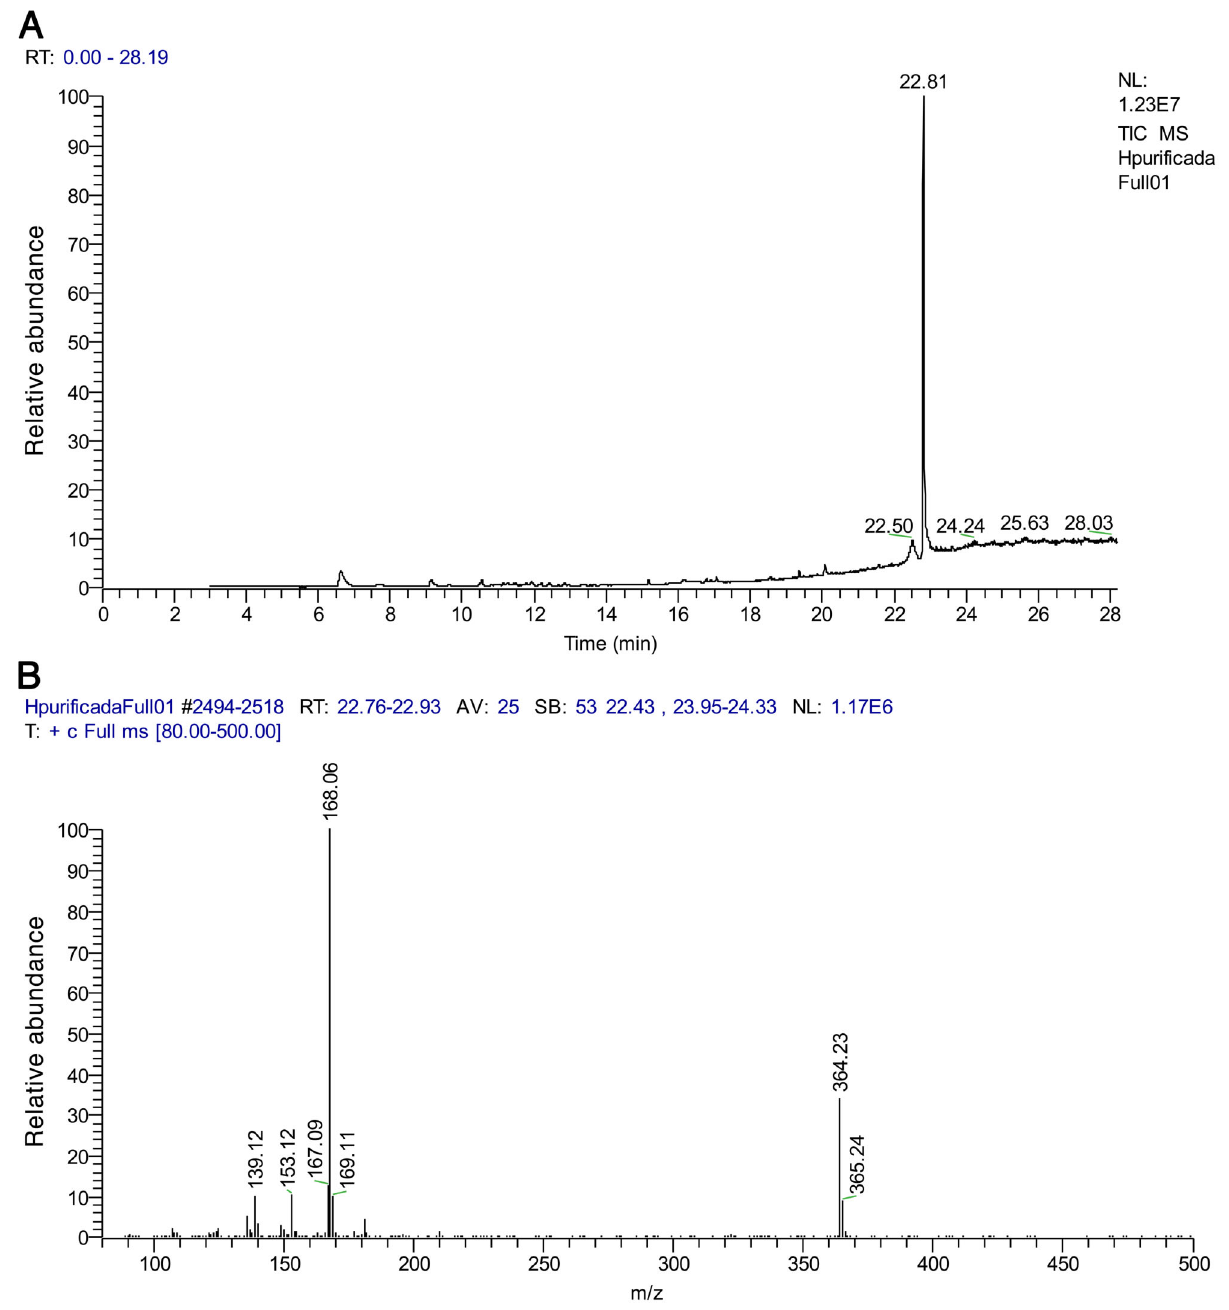
Figure 2. GC-MS analysis of purified 1. Top panel – total ion chromatogram (TIC). Bottom panel – mass spectrum of the main chromatographic peak (RT=28.1 min), with the diagnostic ions for hierridin B at m/z 364 and 168 clearly seen.